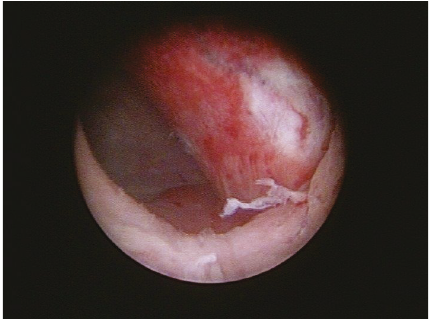
Figure 2: Intraoperative findings during cystoscopy. On the left patient’s side the repositioned ureterocele is to be seen. The ureteral orifice could not be identified.